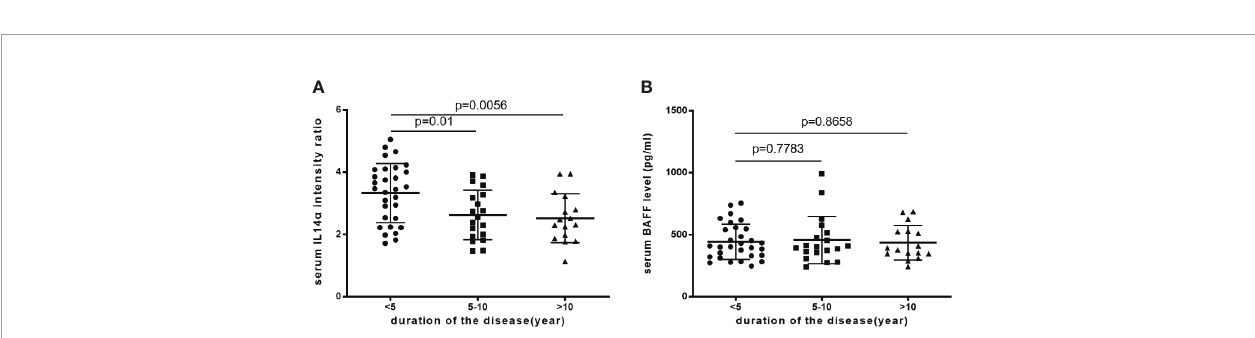
FIGURE 2 | (A) The relationship between serum IL-14 a levels and TSA panel (anti-SP1 antibody, anti-PSP antibody, and anti-CA6 antibody). (B) The relationship between serum IL-14 a levels and anti-Ro antibody. (C) The relationship between serum IL-14 a levels and anti-La antibody.